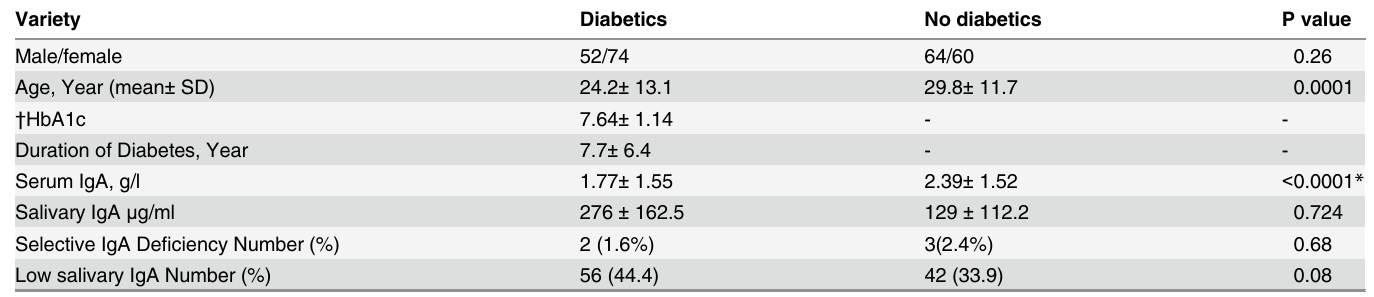
Table 1. Characteristics, Serum and Salivary IgA levels and frequency of Low serum and salivary IgA in Type 1 Diabetic patients and non diabetic subjects.